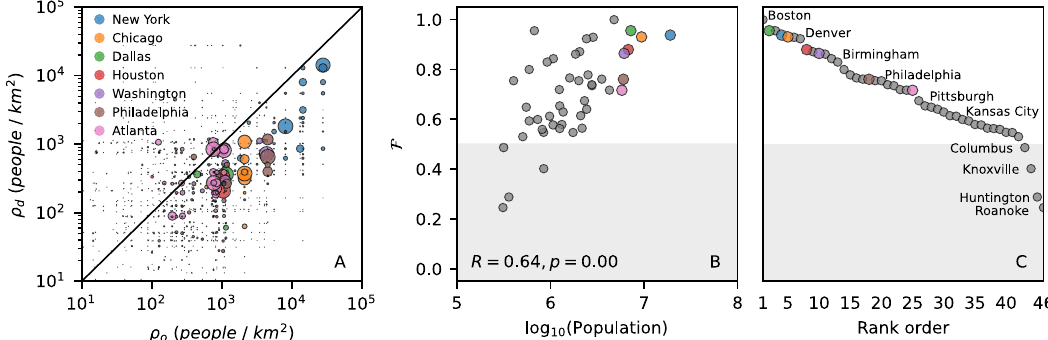
Fig. 4 | People are moving to counties with lower population density. A The population density of the origin ( ρ o ) and destination ( ρ d ) counties of intra-city net fl ows for New York, Chicago, Dallas, Houston, Washington D.C., Philadelphia, Atlanta, reveal that the majority of the fl ows occur from high to low-density counties. The size of the symbols are proportional to the intensity of the net fl ow, and the black line corresponds to y = x . B The fraction of net fl ows to lower